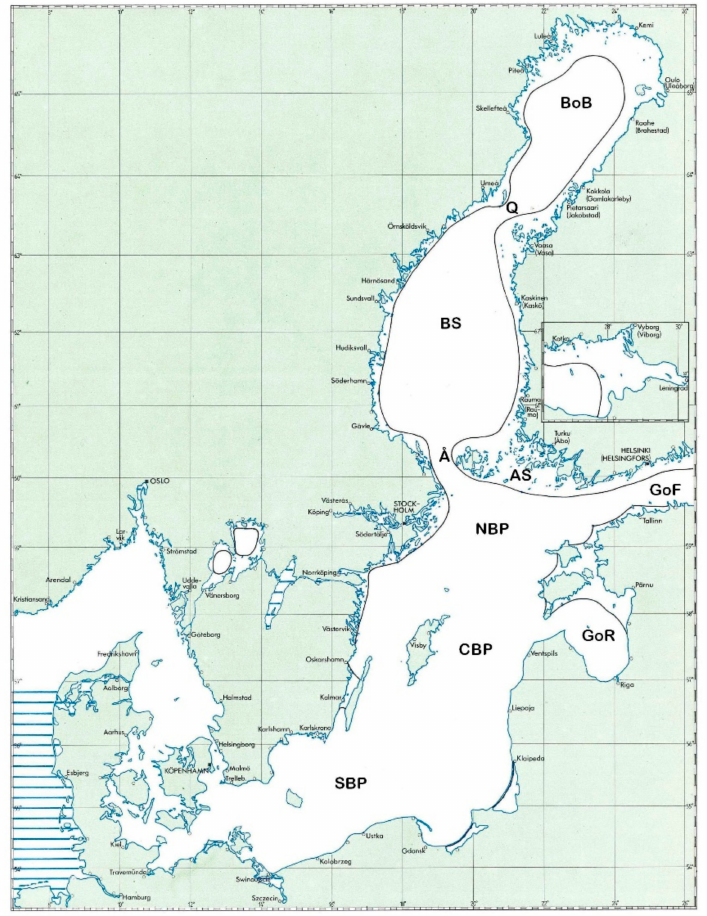
Figure 1. Average landfast ice extent in the Baltic Sea on March 1 [9]. Abbreviations for sea areas: BoB = Bay of Bothnia, Q = Quarken, BS = Bothnian Sea, AS = Archipelago Sea, Å = Åland Sea, GoF = Gulf of Finland, GoR = Gulf of Riga, NBP = Northern Baltic Proper, CBP = Central Baltic Proper, SBP = Southern Baltic